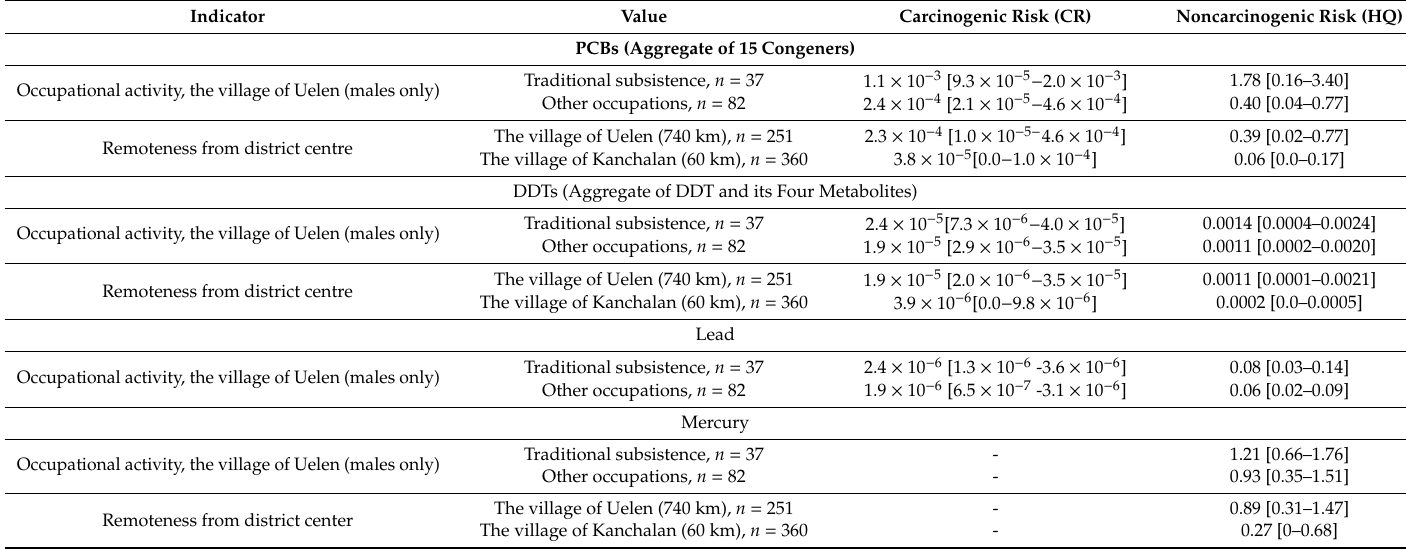
Table 3. Site and activity specific carcinogenic and noncarcinogenic health risks of PCBs, DDTs, mercury (Hg), and lead (Pb) for indigenous people of Chukotka in 2001.